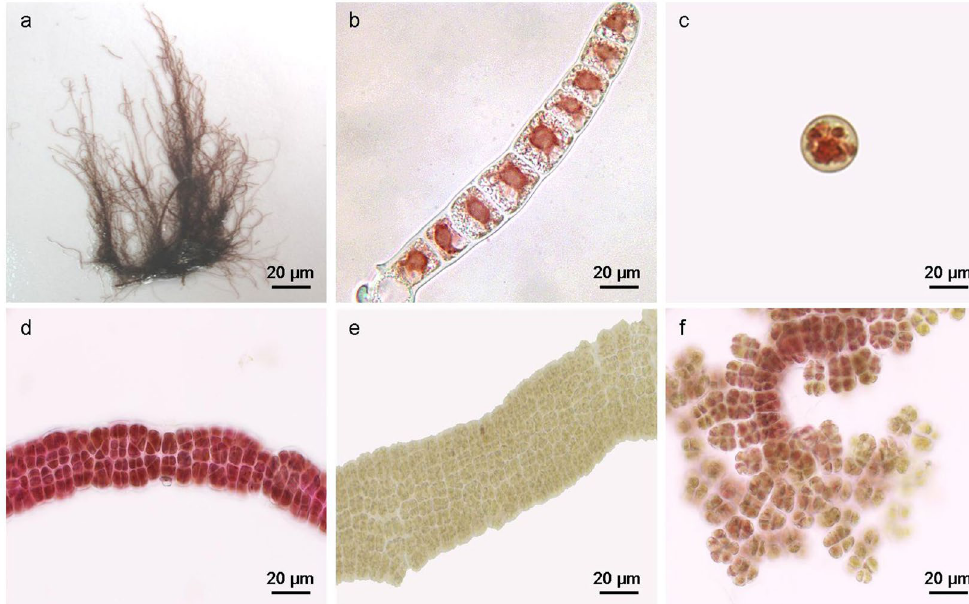
Figure 1. Microscopic structure of the filamentous bangialean ‘Bangia’ sp . OUCPT-01. The thallus had uniseriate or multiseriate unbranched filaments composed of stacked, discoid cells enclosed in a sheath and containing stellate chloroplasts ( a , b ). The thallus releases archeospores ( c ) and forms reproductive cells by direct transformation of the vegetative cells ( d – f